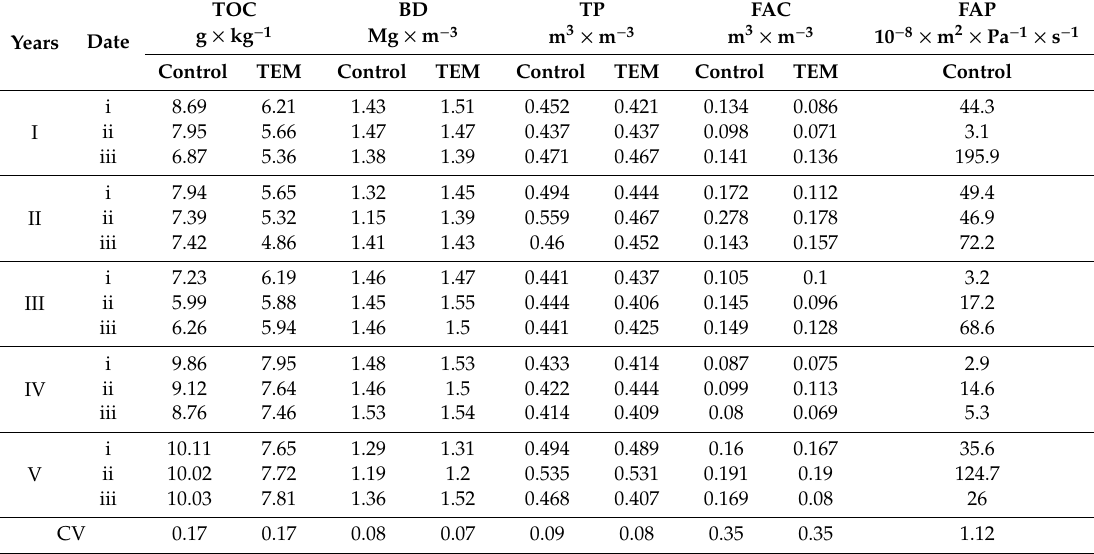
Table 1. Mean values of soil properties on sampling dates.